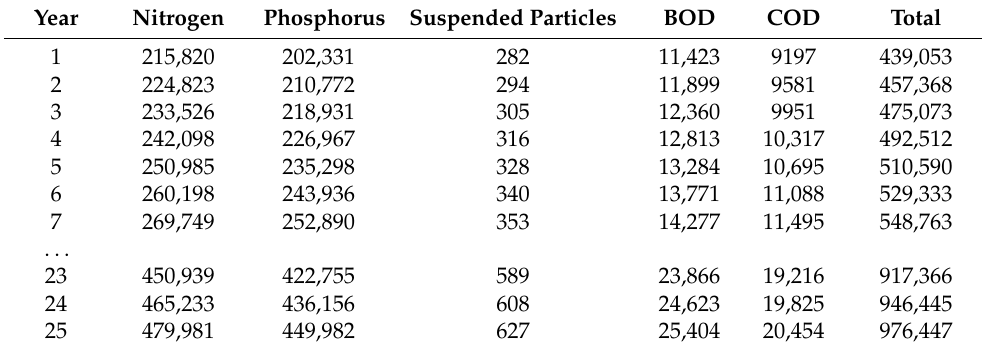
Table 13. Projection of savings in pollution costs (in EUR).